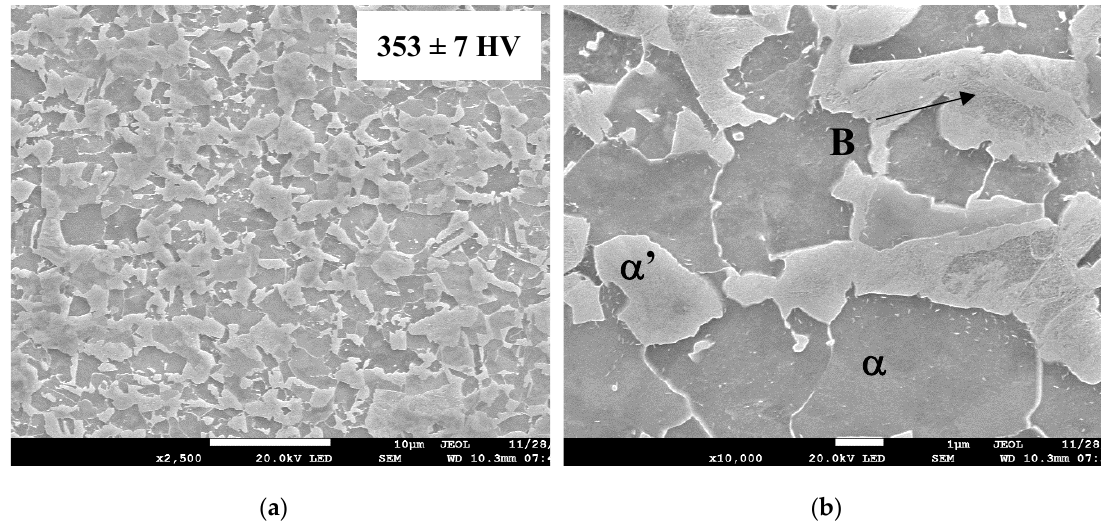
14 of 19 Figure 5. Results of mechanical properties for the experimental tests with optimization results.